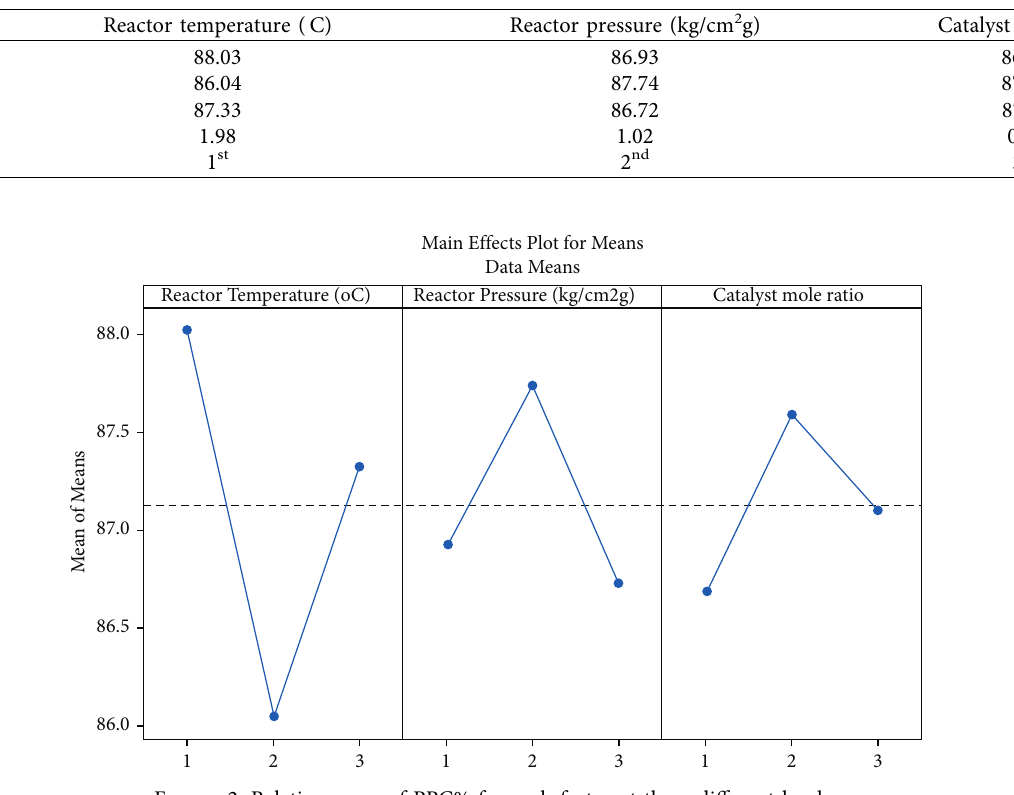
Table 4: Response matrix for per-pass conversion mean (larger is better).